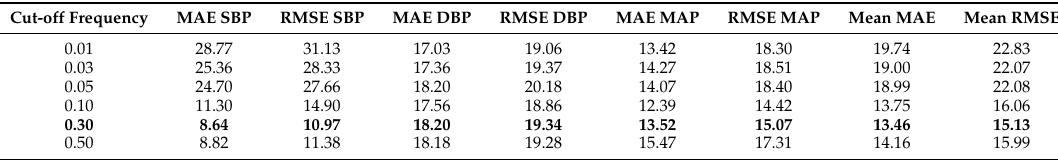
Table 9. Complexity features performance for different cut-off frequencies.